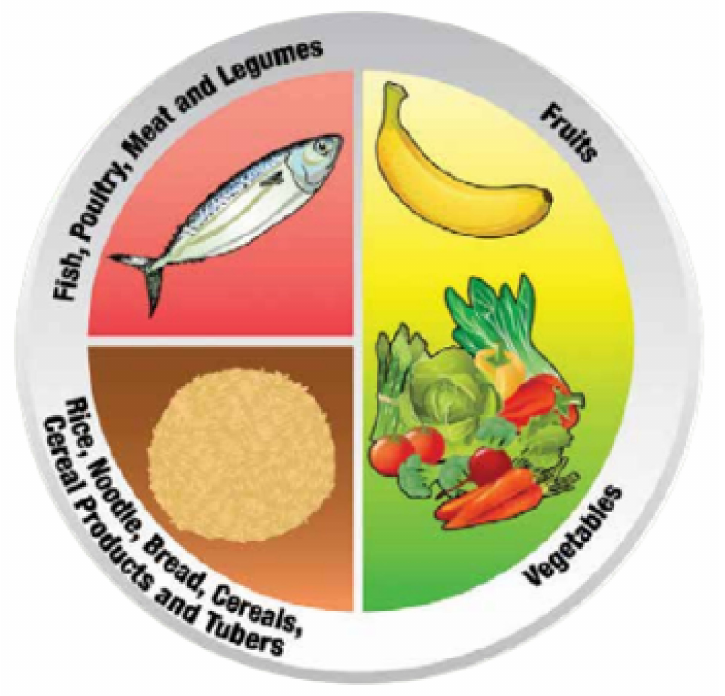
Figure 1. The Malaysian Healthy Plate